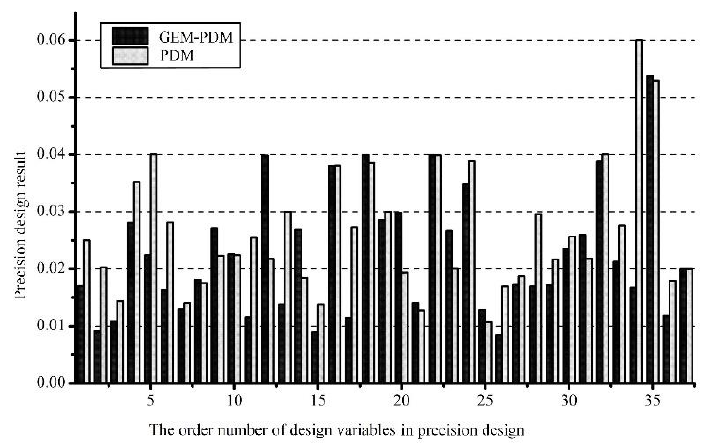
Figure 7. Comparison of the results of precision assignment methods. Table 6. Comparison of the error budgeting results by PDM and GEM-PDM.